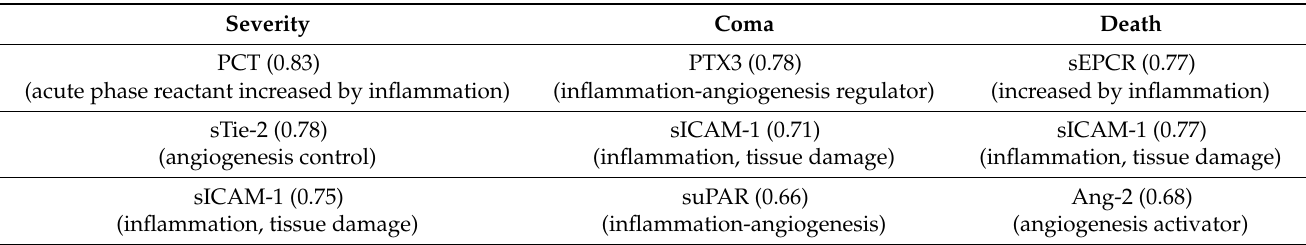
Table 3. The three most predictive biomarkers of severity, coma and mortality are classified according to the AUC results. (AUC values are indicated between brackets as well as some of the main functional characteristics of the